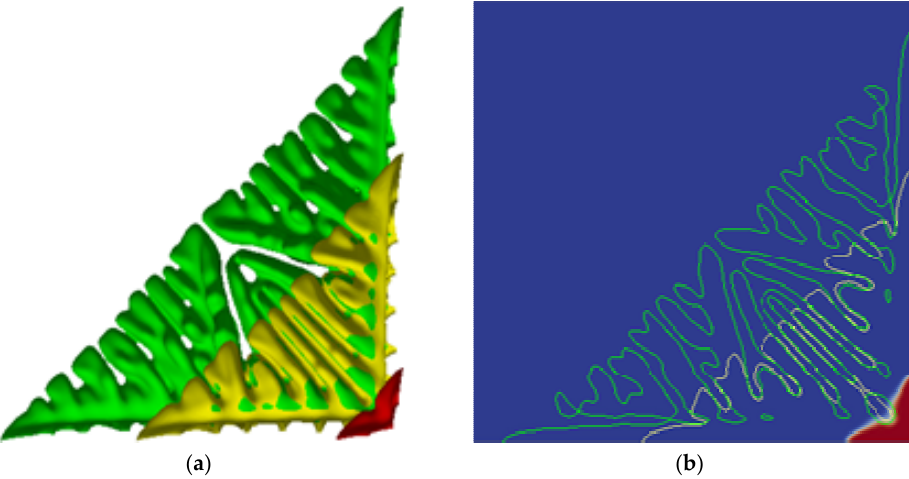
Figure 1. The morphology change of equiaxed dendrite growth. ( a ) Morphology of dendrite with a step size of 2000 (red), 8000 (yellow), and 12,000 (green); ( b ) Comparison of dendrite profile at the interface with a step size of 2000 (red), 8000 (yellow), and 12,000 (green).